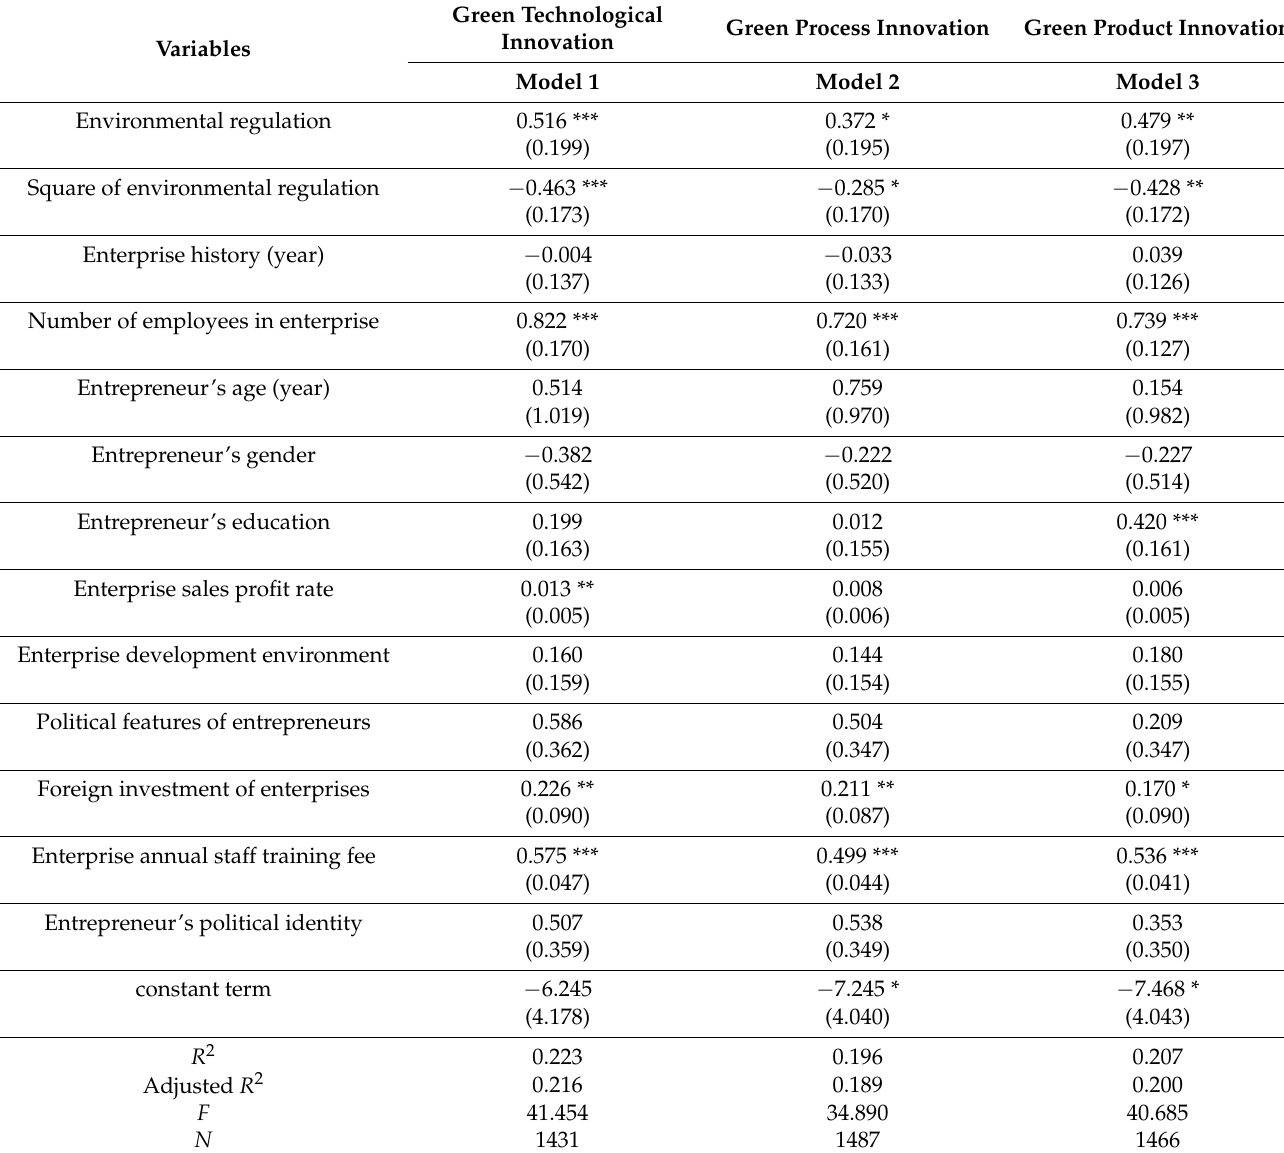
Table 3. Impact of environmental regulation on enterprise green technological